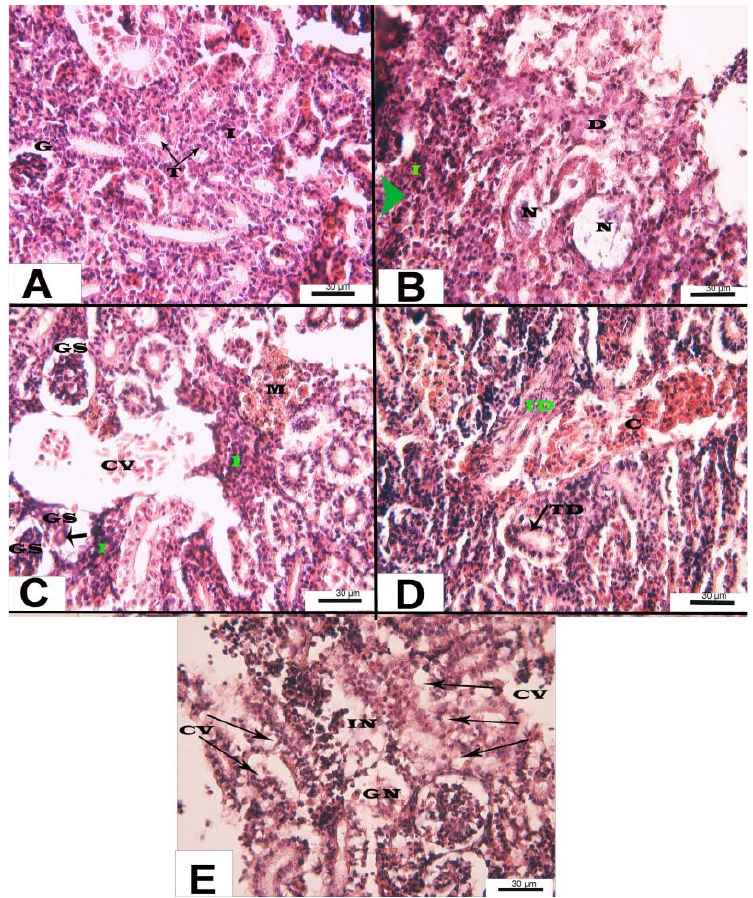
Fig. 4: Micrographs of the kidney of Caspian roach (Stained by Hematoxilin and Eosin) [A] Normal kidney tissue, the glomerules and the Bowman’s space well defined (G) Tubules (Tu), interstitial tissue (I) [B] Cellular degeneration (De), Glomerular necrosis (N) Increase in interstitial tissue cells (I) [C] Glomerular shrinkage (GSh), Increase in interstitial tissue cells (I), Macrophages aggregation (M), Central vein (V) [D] Interstitial tissue degeneration (IDe), Congestion (C), Tubule degeneration (TD) [E] Cellular vacuolation (CeV), Glomerular necrosis (GN), Interstitial tissue necrosis (IN)